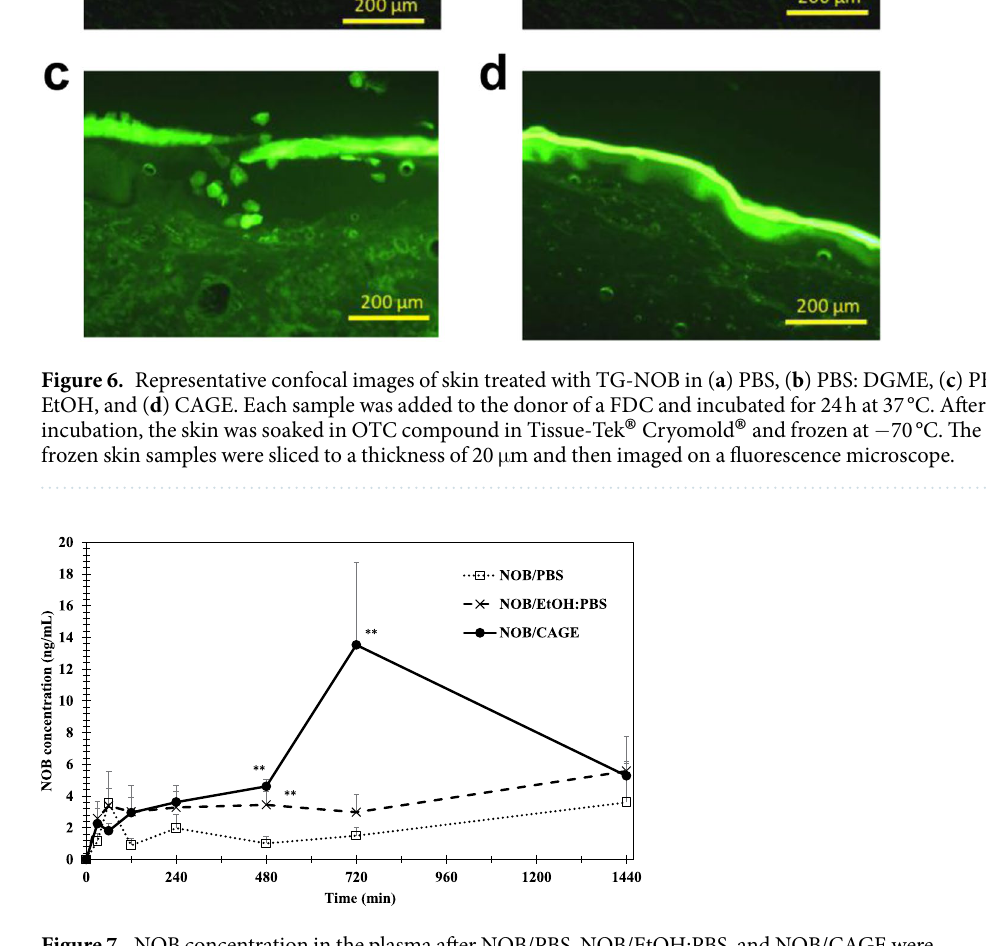
time for maximal concentration ( T max ); and AUC 0-1440min ; absolute BA are shown in Table 2. In particular, the values for the AUC 0-1440min of NOB/PBS, NOB/EtOH: PBS, and NOB/CAGE calculated by the linear trapezoidal method were 2.89 ± 0.91, 5.35 ± 1.43, and 10.57 ± 2.50 μ g/mL • min, respectively, and the value for NOB/CAGE was approximately 1.9-fold and 3.7-fold higher compared with the others. Moreover, absolute BAs of NOB/PBS, NOB/EtOH:PBS, and NOB/CAGE were calculated to be 2.47%, 4.58%, and 9.04% respectively. These results suggested that the absorption of NOB was improved using CAGE compared with the other enhancers in vivo . Hypoglycemic activity of the noB/cAGe sample transdermally administrated to SD rats. Finally, the transdermal hypoglycemic activity of different samples of NOB was tested using SD rats. The sam- ples were PBS, NOB/PBS, and NOB/CAGE (Fig. 8). A 22% drop in the blood glucose level (BGL) was observed at 120 min after PBS administration. After that, the level remained constant until 1440 min. Approximate drops of 10–20% in the BGL were observed until 720 min after NOB/PBS administration, then a 27% decrease was observed over 720–1440 min. Using NOB/CAGE, a significant 34% drop in the BGL was observed from